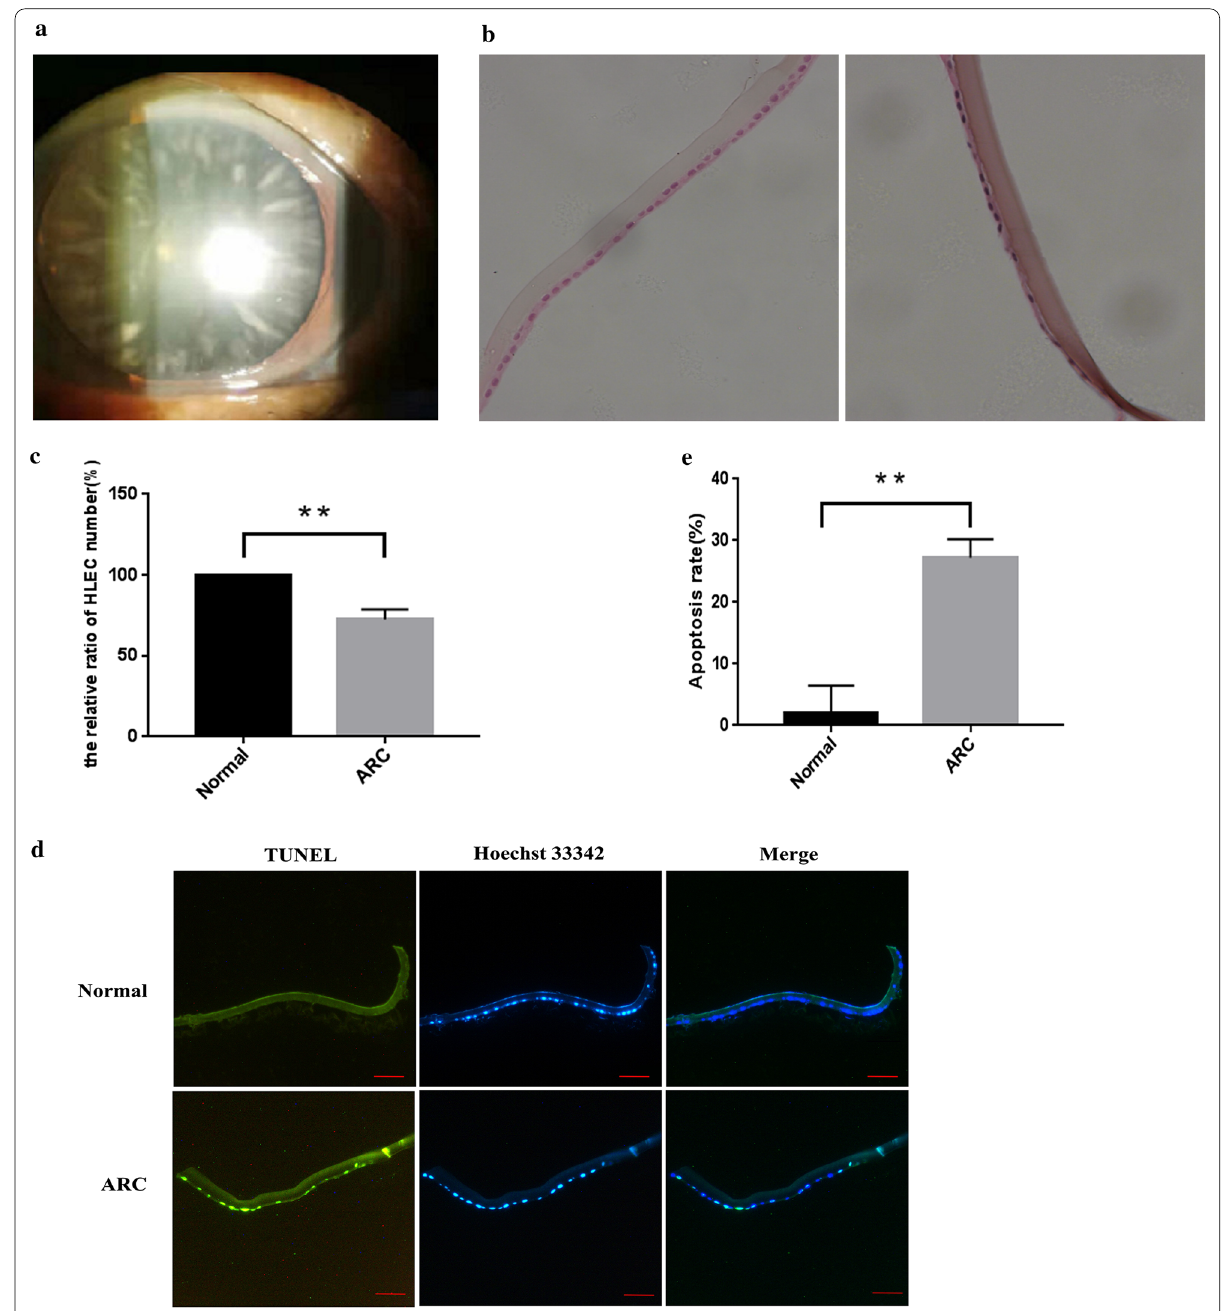
Fig. 1 Lens epithelial cells apoptosis was associated with the age-related cataract base on human samples. a Representative slit-lamp image of the lens with cortical opacity of cataract. From the representative patient, the slit lamp biomicroscopy examination showed the cortical cataract with age. Because the normal subjects with transparent lens were enrolled from corneal transplant donors and ocular trauma patients with lens detachment, a picture of normal control cannot be obtained. b Decreases in LECs density from the cataract patients compared to the control individuals using HE staining of whole lenses. The patient lens epithelial cells showed cell nuclei shrinkage, chromatin condensation, and fragmented nuclei by nuclei stained with hematoxylin. Scale bar: 20 µm. c The cell density was determined by counting nuclei stained with the hematoxylin in 5 randomly selected fields from three experiments and are shown as means SD. **p < 0.01 versus the LECs from control individuals. ± d Apoptotic LECs increased in ARC patients. The red arrows point to the apoptotic cells with both positive TUNEL and Hoechst 33342 staining. The yellow arrows point to the non-apoptotic cells with TUNEL-negative staining. Scale bar: 100 µm. e The apoptotic cell numbers were determined by TUNEL assay. Counting both positive TUNEL and Hoechst 33342 cells in 5 randomly selected fields from three experiments and are shown as means SD. **p < 0.01 versus the LECs from control ±